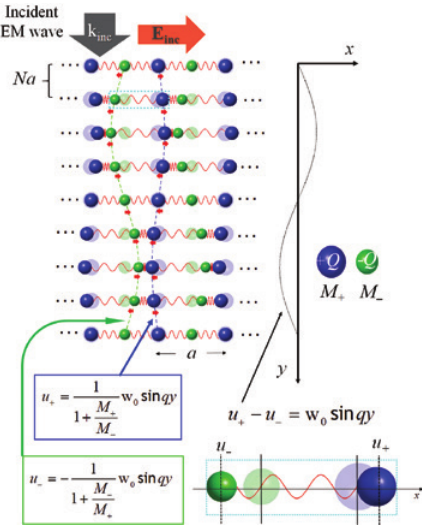
Figure 5: The transverse PhP